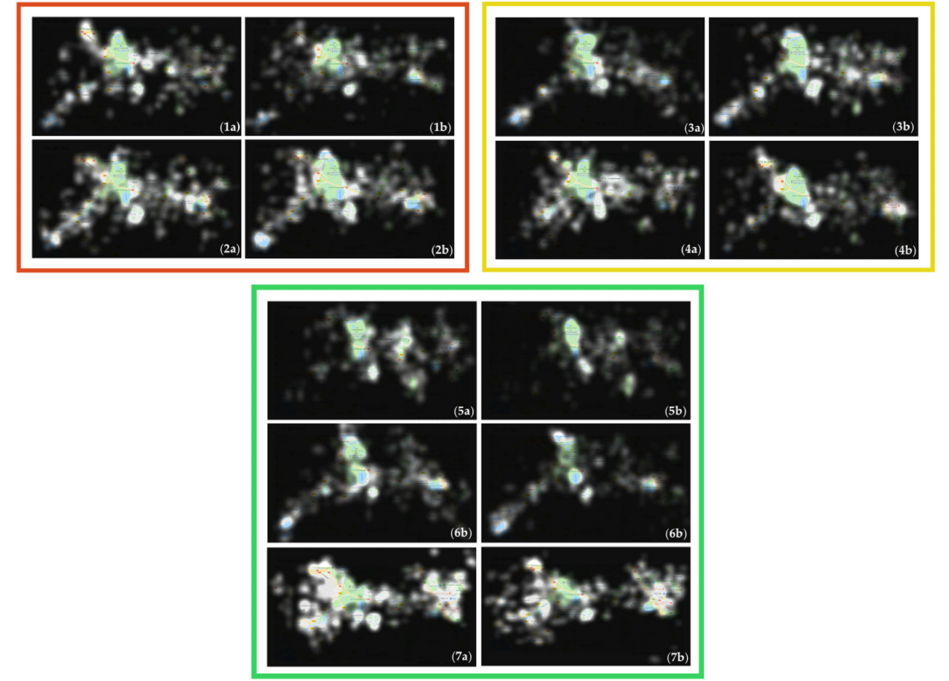
Figure 6. Focus maps belonging to the example stimulus in Figure 1. The maps in the red rectangle represent hard tasks: ( 1a ) Block 1—experts, ( 1b ) Block 1—novices, ( 2a ) Block 2—experts, ( 2b ) Block 2 —novices. The maps in the yellow rectangle represent moderate tasks: ( 3a ) Block 3—experts, ( 3b ) Block 3 —novices, ( 4a ) Block 4—experts, ( 4b ) Block 4—novices. The maps in the green rectangle represent easy tasks: ( 5a ) Block 5—experts, ( 5b ) Block 5—novices, ( 6a ) Block 6—experts, ( 6b ) Block 6—novices,